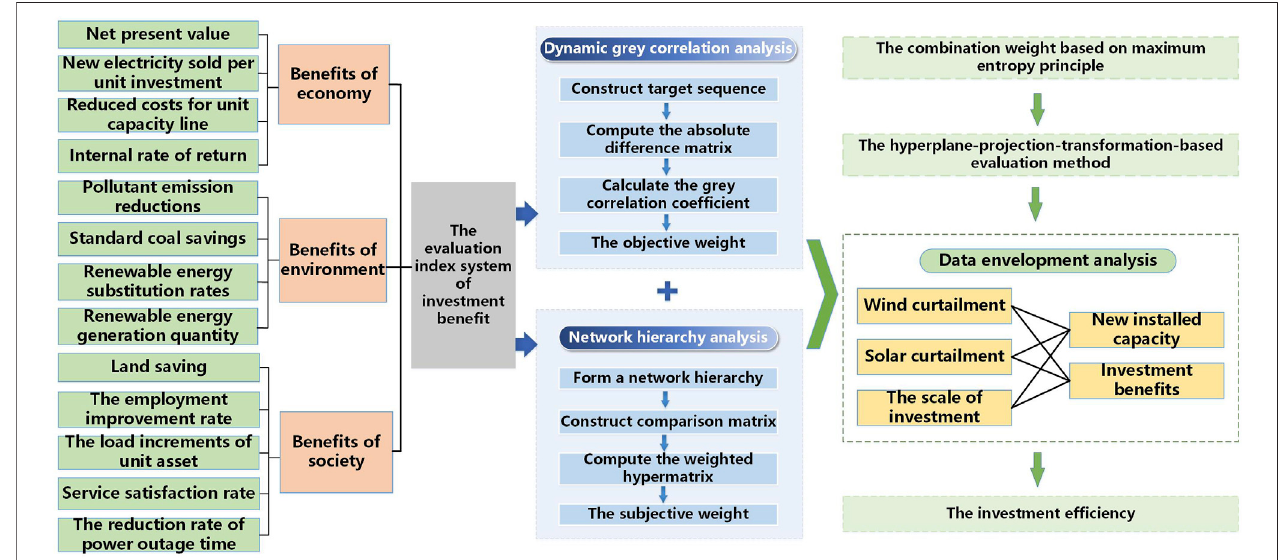
FIGURE 1 | An investment ef fi ciency evaluation